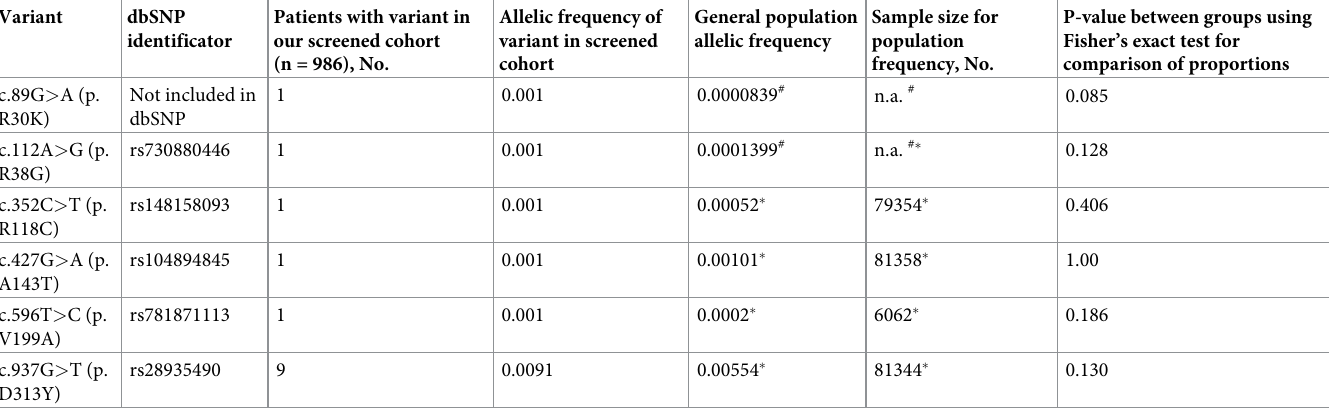
Table 4. GLA variants considered benign or with unclear clinical significance discovered in our study and their population